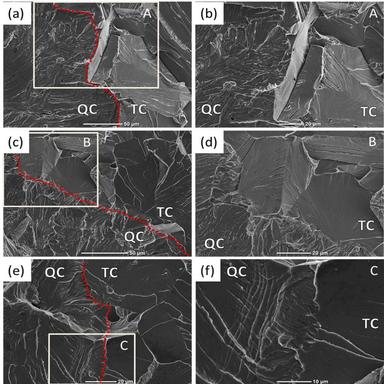
The morphology of the fracture surface at the boundary between the QC and TC regions in the technically pure iron – (a, b), Fe-2.5%Si alloy – (c, d) and lowcarbon steel S235JR – (e, f) specimens. The magnified areas outlined by letter-labelled frames "A", "B" and "C" on images (a), (c) and (e) are represented on figures (b), (d) and (f), respectively. The dotted curves on images (a), (c) and (e) indicate the boundary between the QC and TC regions.